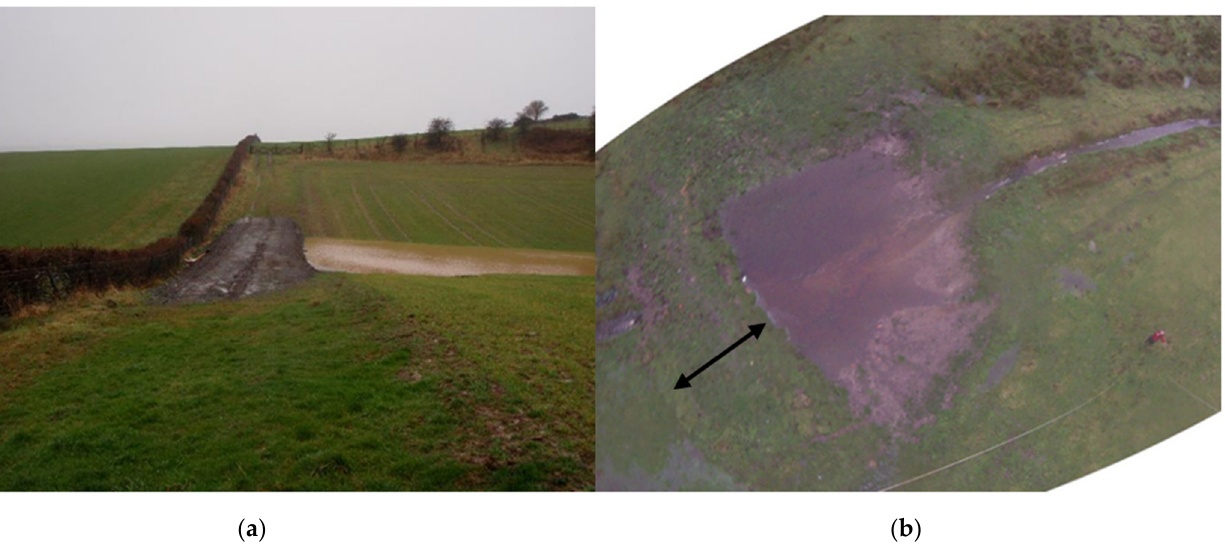
Figure 3. Online ponds: Overland flow interception at ( a ) Belford Burn catchment and channel pond. ( b ) Slatey Sike positioned at 1 km 2 along the channel (Tyne Rivers Trust and Newcastle University), the arrow indicates approximately 10 m for the bund width.